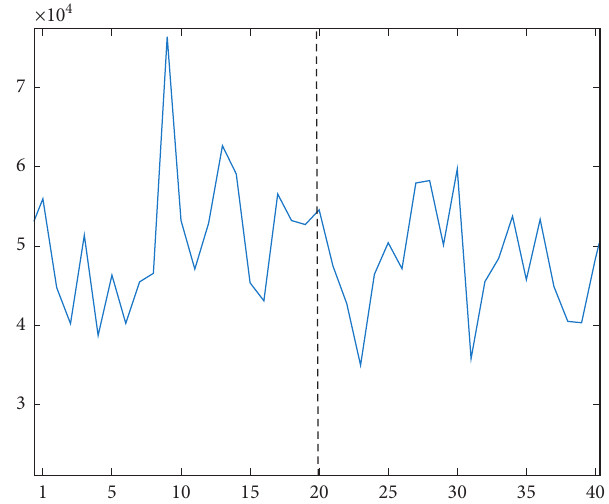
Figure 2: The changes in the daily buying order volume for the IC dominant contract.